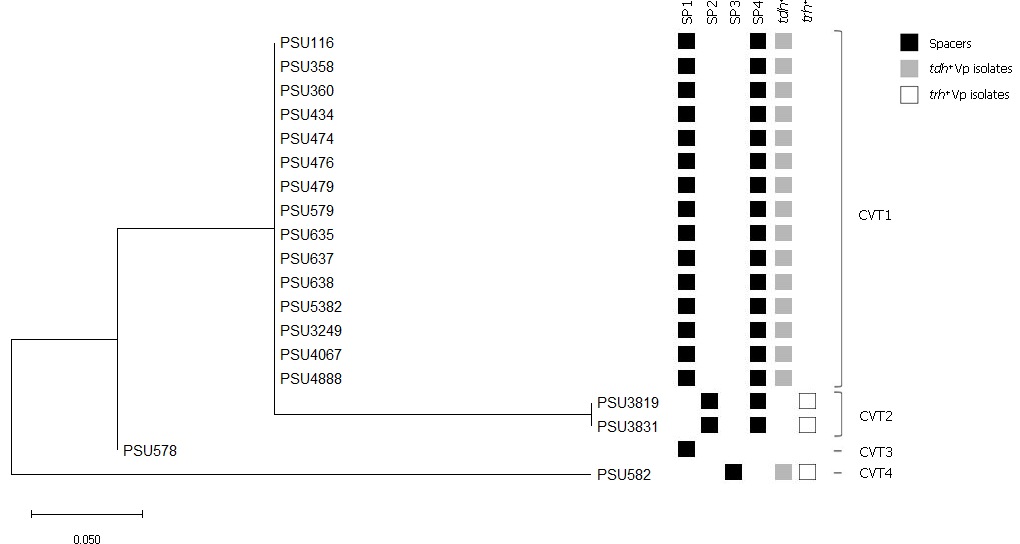
Figure 5. Dendrogram of the 19 CRISPR-positive V. parahaemolyticus seafood isolates. The maximum likelihood method was used for constructing the phylogenetic tree. The bar represents a 5% dissimilarity between the two sequences. Colors within the squares correspond to the presence of spacer and virulence genes.